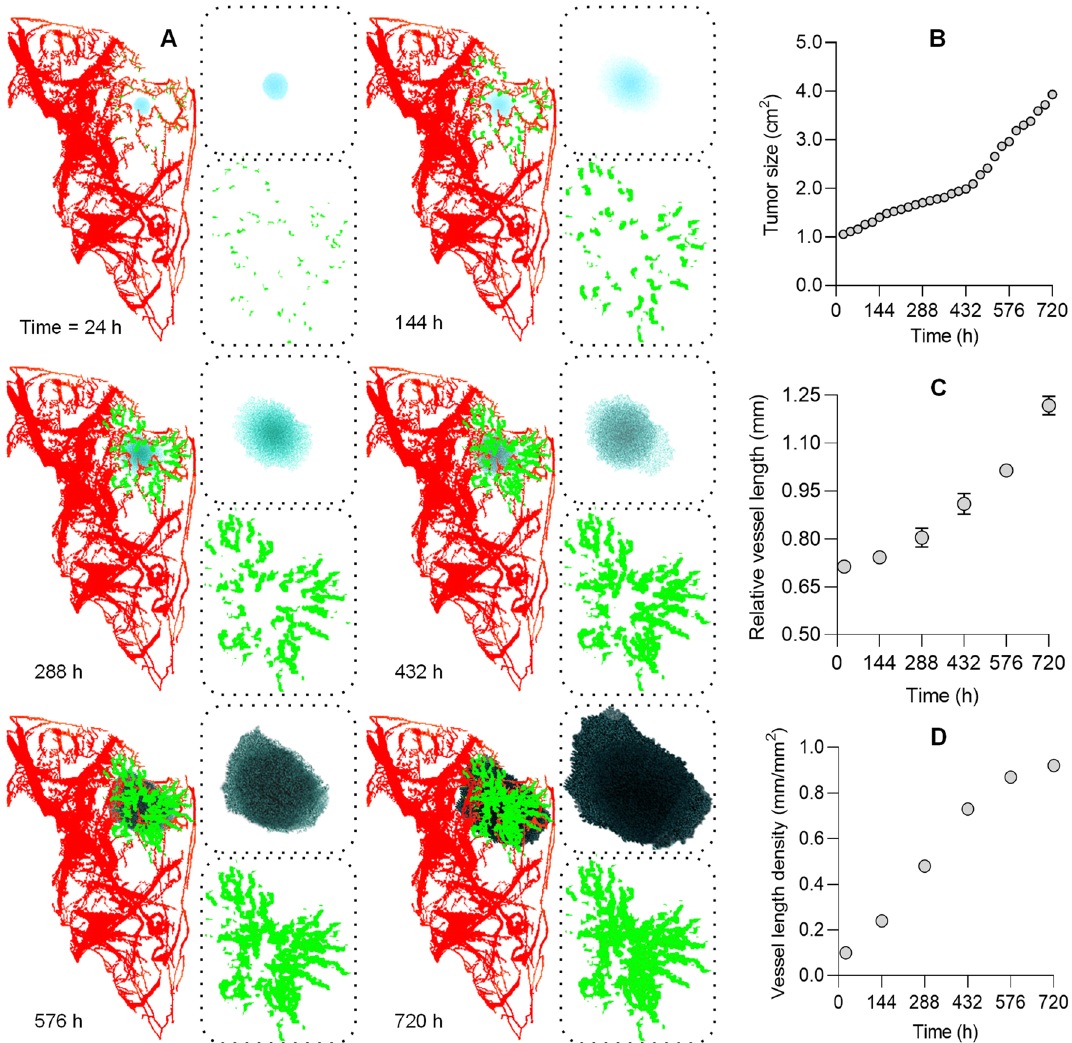
Figure 1. ( A ) Representative multiscale computational model results of tumor growth and microvessel development for a simulation period of 30 d. Model initialization was performed using spatial input data from the in vivo contrast-enhanced microscale computed tomography (microCT) image of the segmented tumor microvascular network (red). New simulated microvascular segments (green) tend to grow toward the tumor location in response to a vascular endothelial growth factor (VEGF) gradient produced by hypoxic cancer cells. ( B ) Simulated changes in tumor size follow the classic exponential growth model. Initially, ( C ) existing vessel length is insufficient to supply the necessary nutrients to hypovascular areas before new microvascular growth, ( D ) leading to increased intratumoral vessel density, which is an indicator of tumor